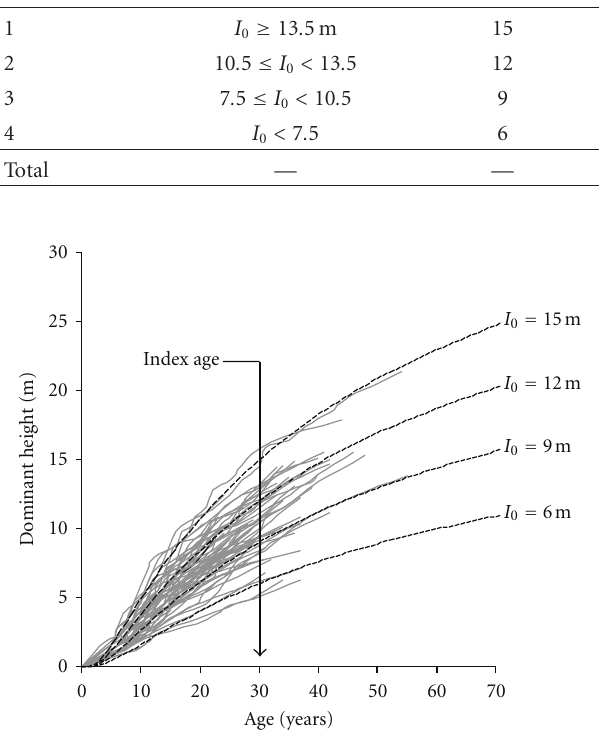
Figure 9: Height growth curves obtained with model M6 for site index values of 6, 9, 12, and 15 m at the reference age of 30 years, overlaid on the trajectories of the observed heights of sampled trees over time.